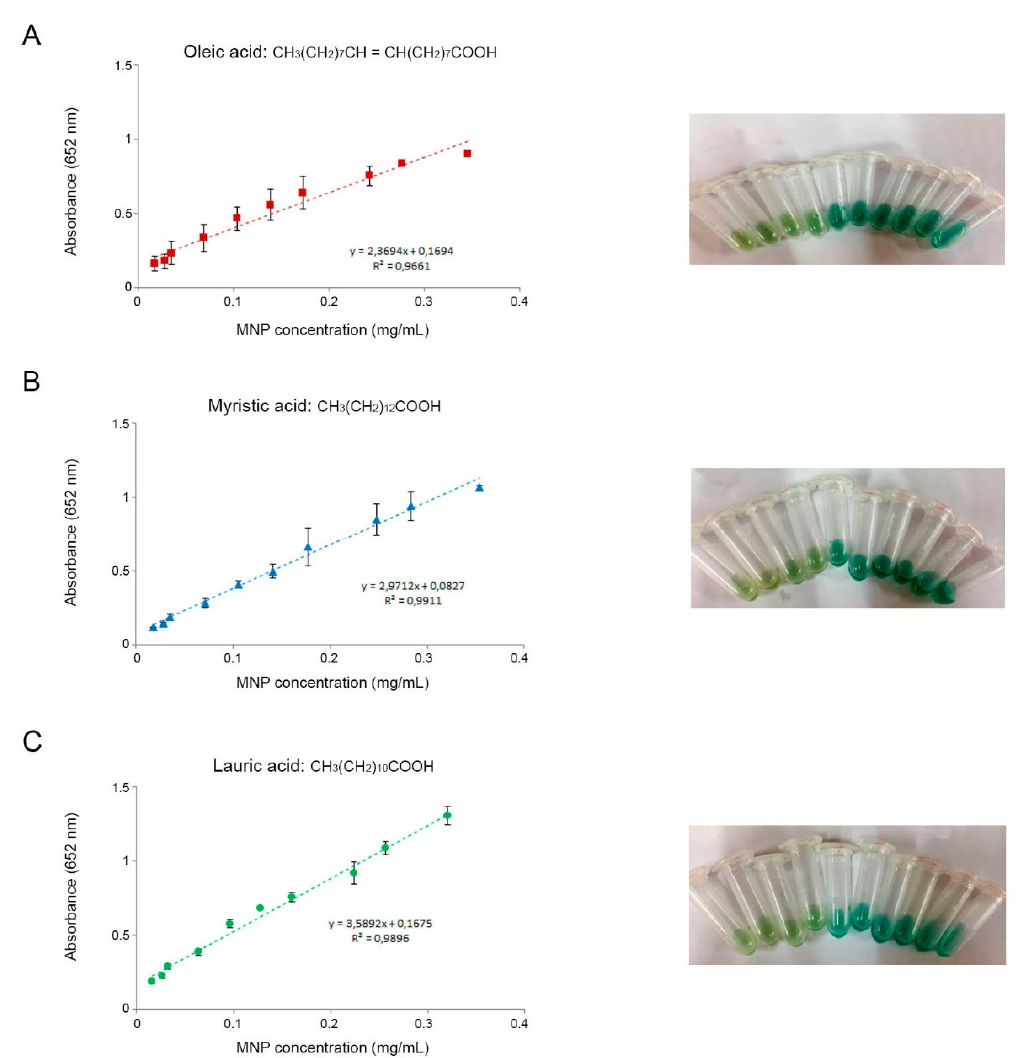
Figure 2. Calibration curves using the nanozyme properties (peroxidase-like activity) of MNPs coated with ( A ) oleic acid, ( B ) myristic acid, and ( C ) lauric acid. Graphs show the mean ± SD of three independent experiments. Representative images of the color developments at the different concentrations tested are shown for each type of MNP.